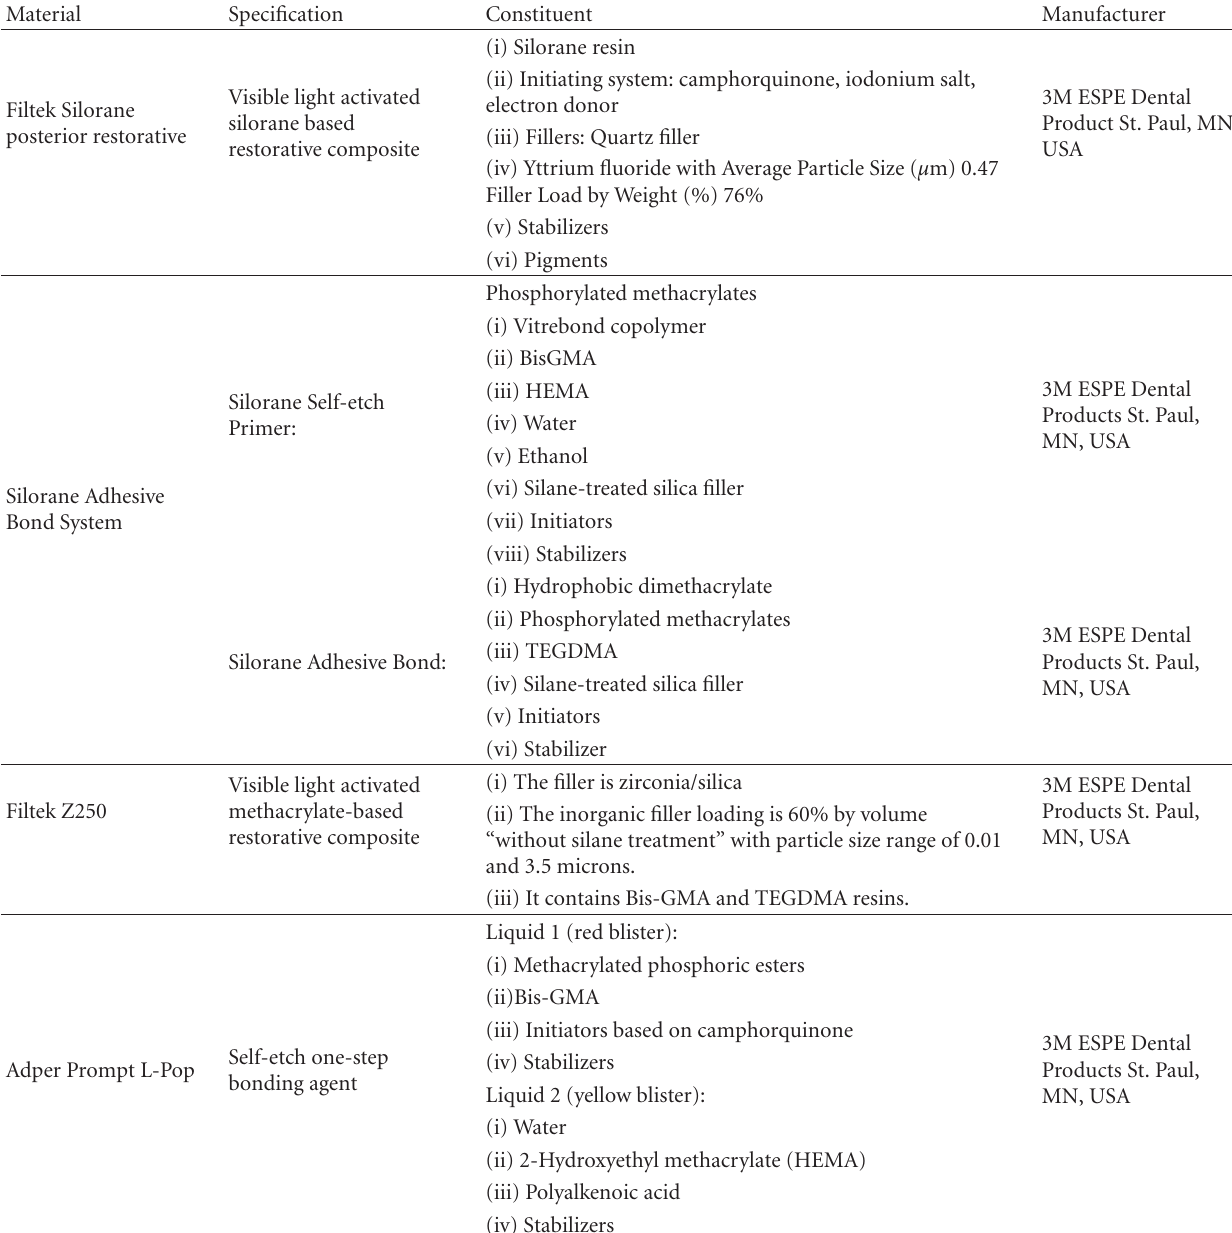
Table 1: Specification, constituent, and manufacturers for adhesives and composite resins used in the study.